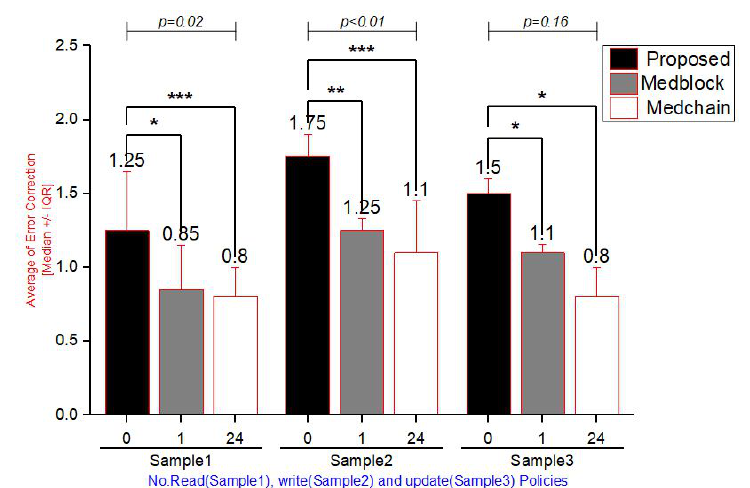
Figure 12. Comparative analysis of the number of various access control policies and a comparison with the benchmark models